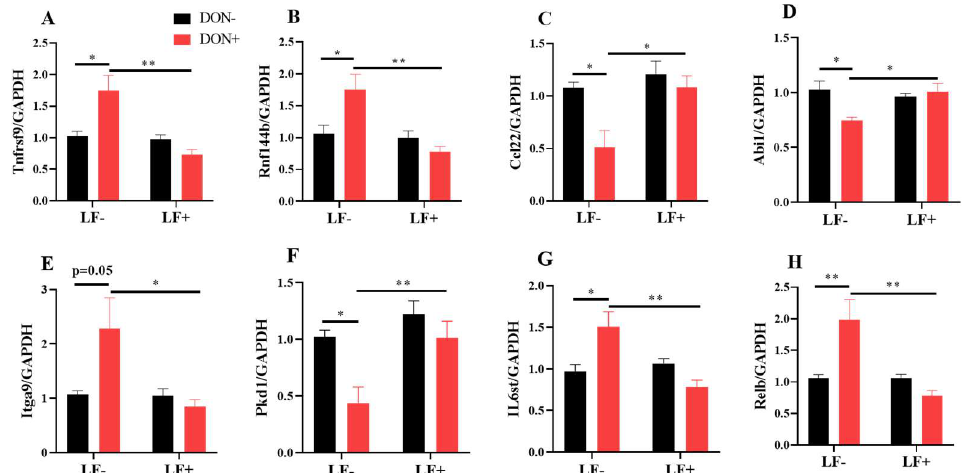
Figure 7. The mRNA transcript level of genes involved in inflammatory response and cell